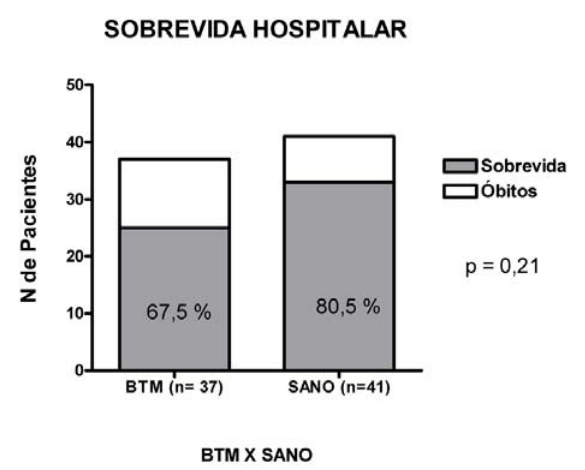
Fig. 2 - Sobrevida hospitalar na síndrome do coração esquerdo